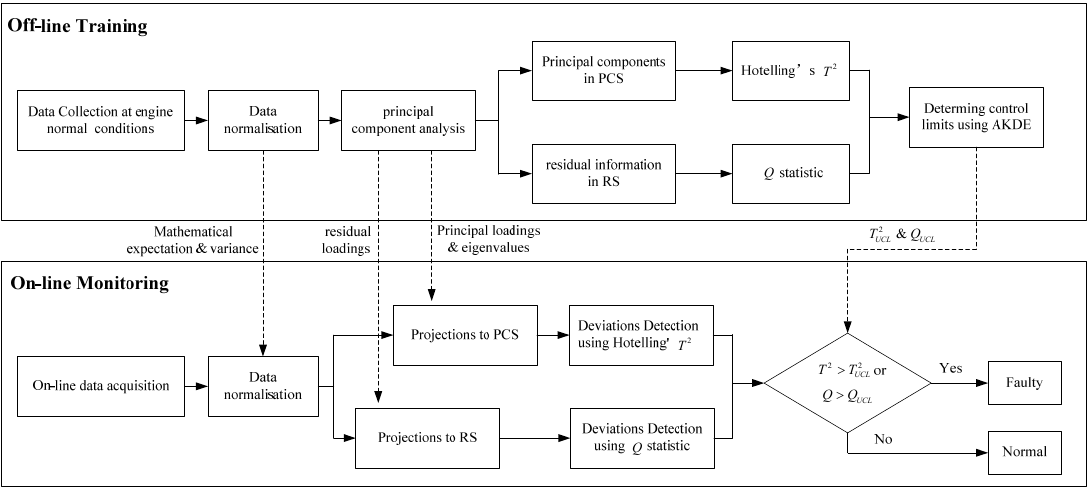
Figure 3. Technical procedure for diesel engine fault detection.